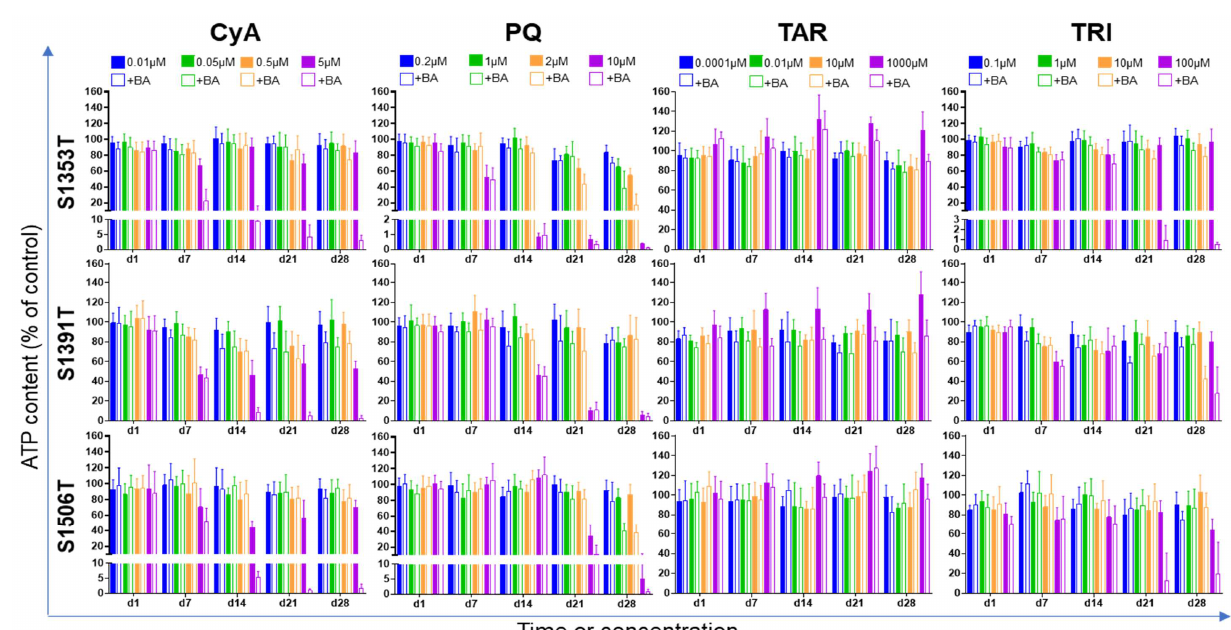
Figure 3. Effects of a concentrated BAs mixture on the hepatotoxicity of the test compounds throughout time. Spheroids from three different PHH donors were repeatedly incubated for 1, 7, 14, 21 and 28 days with the specified test compound in the presence (empty bars) and in the absence (filled bars) of a 30× concentrated mixture of BAs. At each predefined time-point, total ATP content was quantified. The effect of vehicle alone (control) was taken as 100%. Results are expressed as mean ± standard deviation of at least six spheroids per condition. ATP—adenosine triphosphate; BA—bile acid; CyA—cyclosporine-A; d—day; PQ—paraquat; TAR—tartrazine; TRI—triclosan.